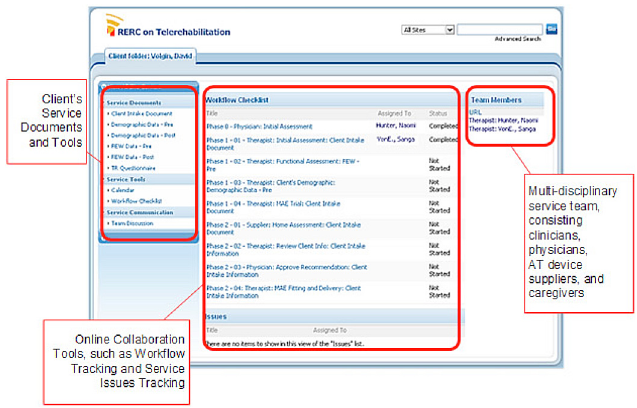
Figure 5. Remote Wheelchair Prescription Online Portal